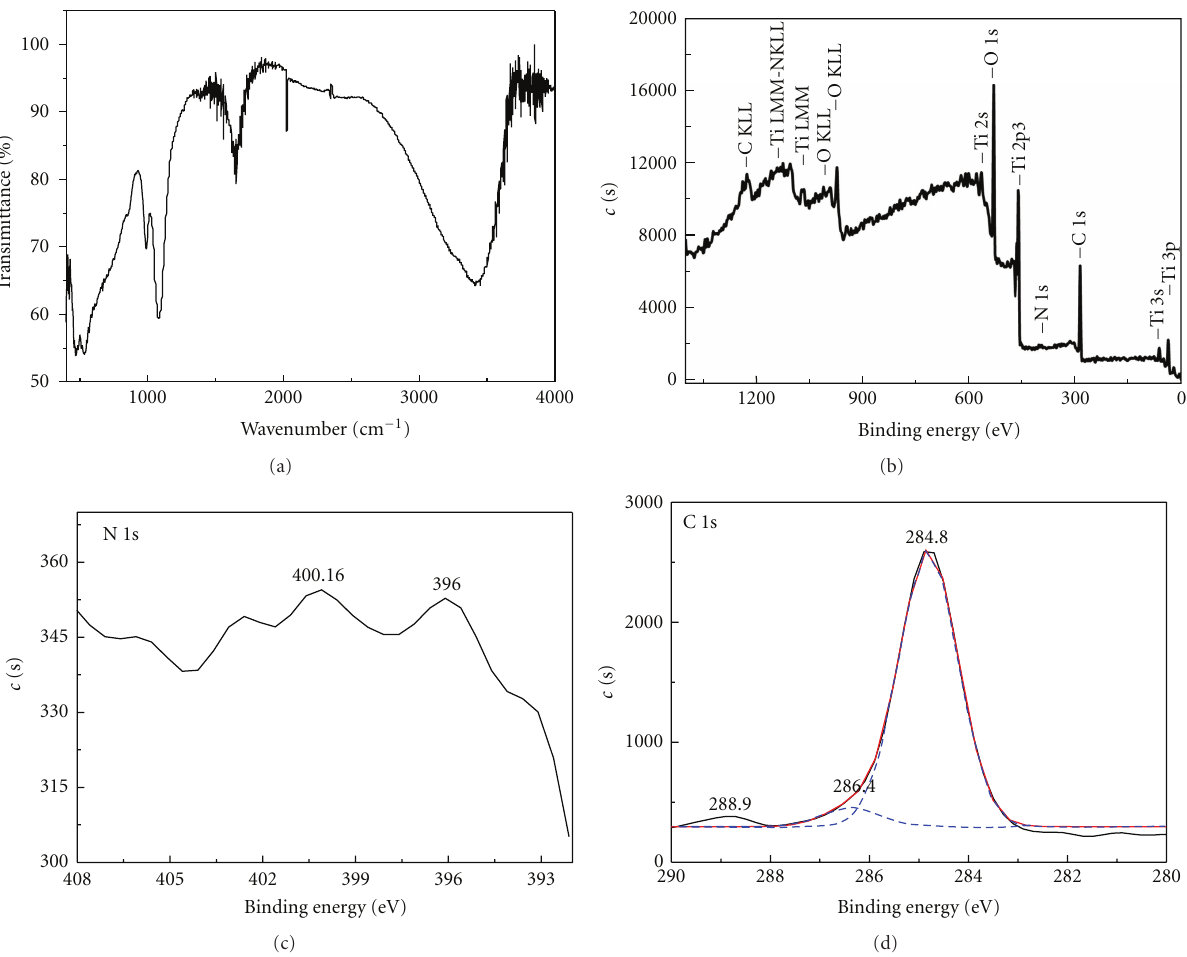
Figure 5: (a) FT-IR of the mesoporous TiO 2 . ((b)–(d)) XPS of the mesoporous TiO 2 : survey (b) and deconvoluted spectra for N 1s (c) and C 1s (d).